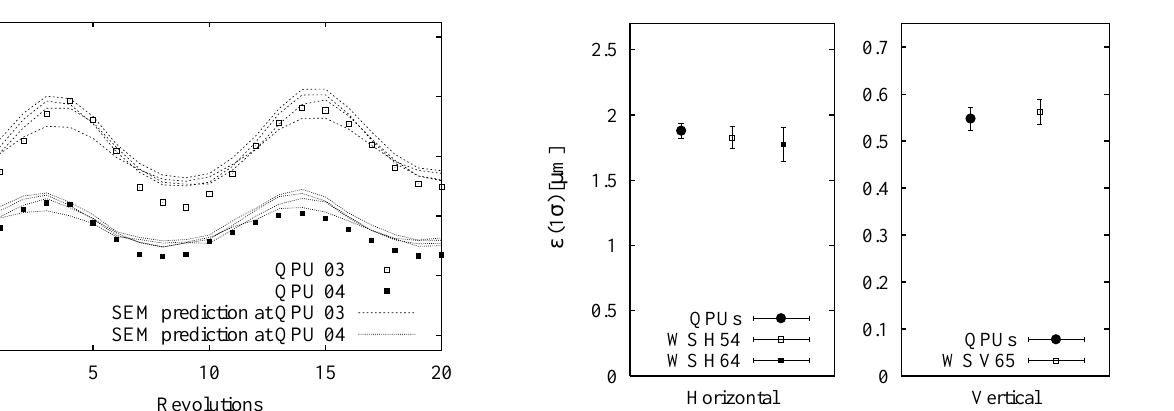
FIG. 5. Beam-size oscillations at injection measured with the quadrupole pickups and a turn-by-turn SEM grid. The SEM-grid beam-size data were used to calculate the expected quadrupole moment at the pickup locations. Beam position contributions and known pickup offsets have been subtracted from the quadrupole moments.